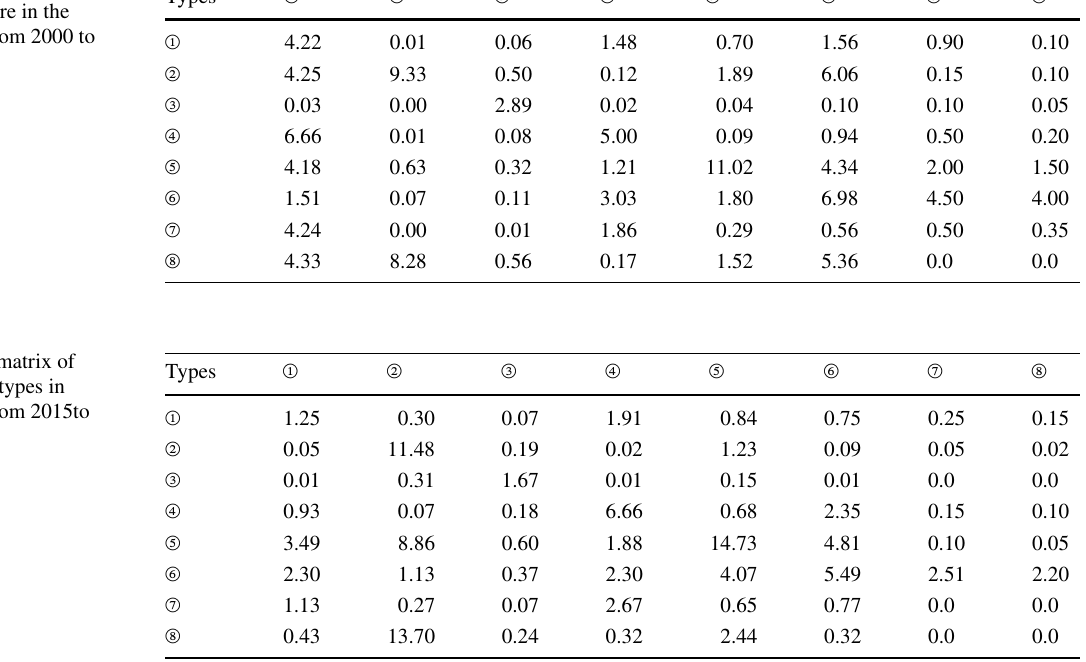
of wetland structure in the Dongping Lake from 2000 to 2015 (km 2 )